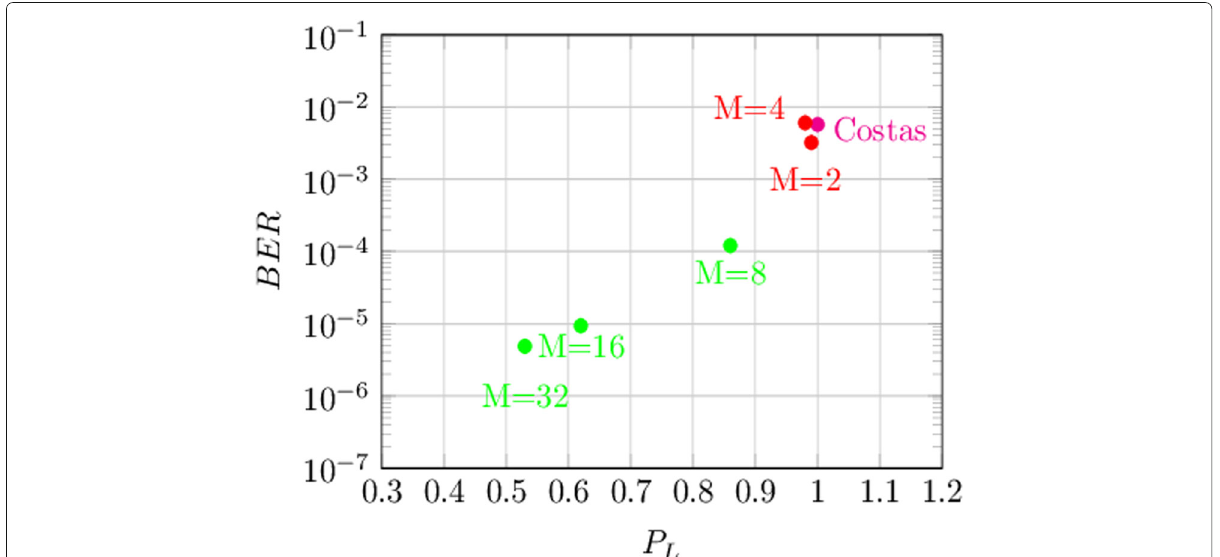
Fig. 10 Error rate of Costas’ loop and some recovery loops varying the parameter M when Eb/N0 = 0 dB. The presence of an analog loop lowers the in-lock probability PL and optimizes the error rate than Costas’